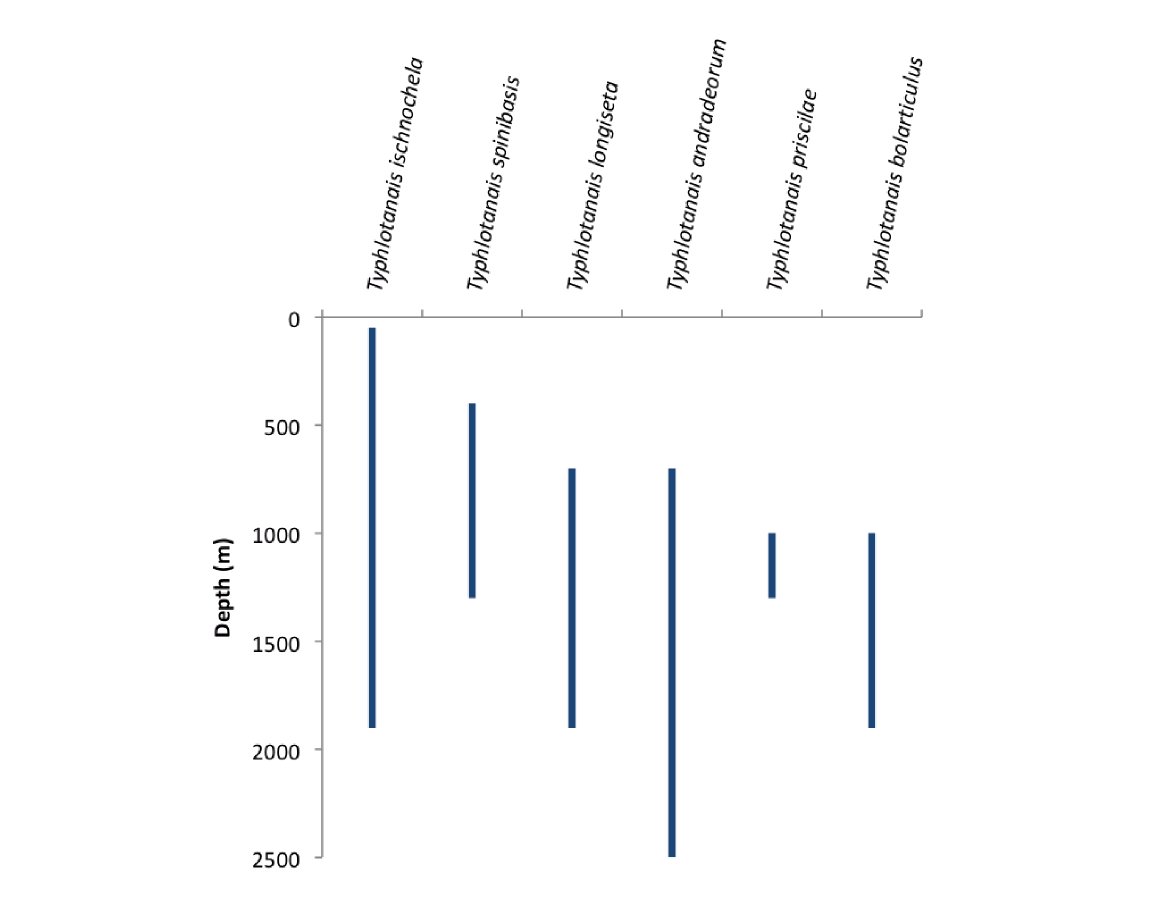
Fig. 21. Bathymetric range of species of Typhlotanais along the Brazilian coast (19° S–24° S) based on samples listed in Table